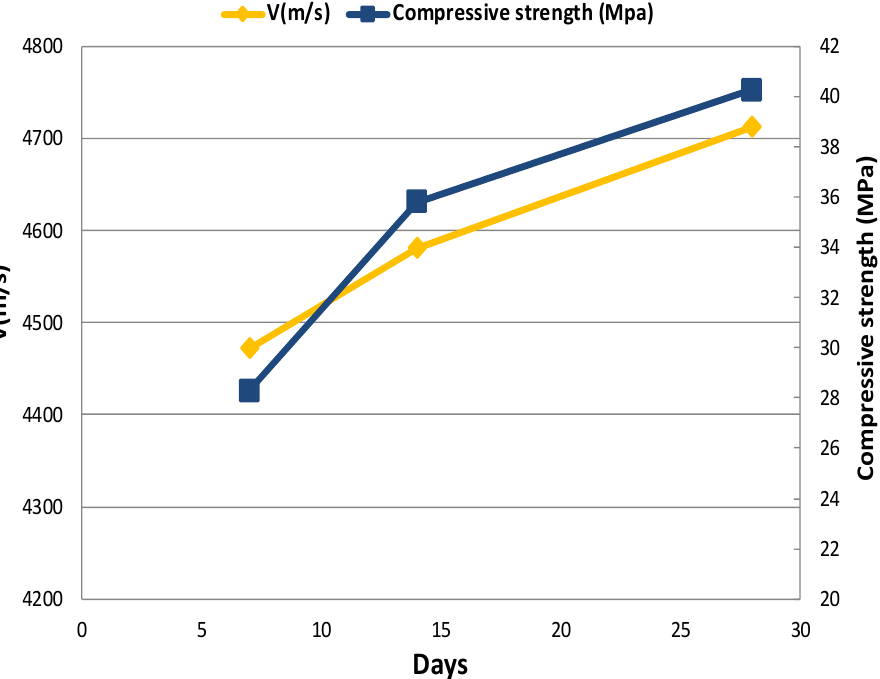
Figure 16. Comparison of UPV and compressive strength at 5% replacement of gravel (G-J-S) .